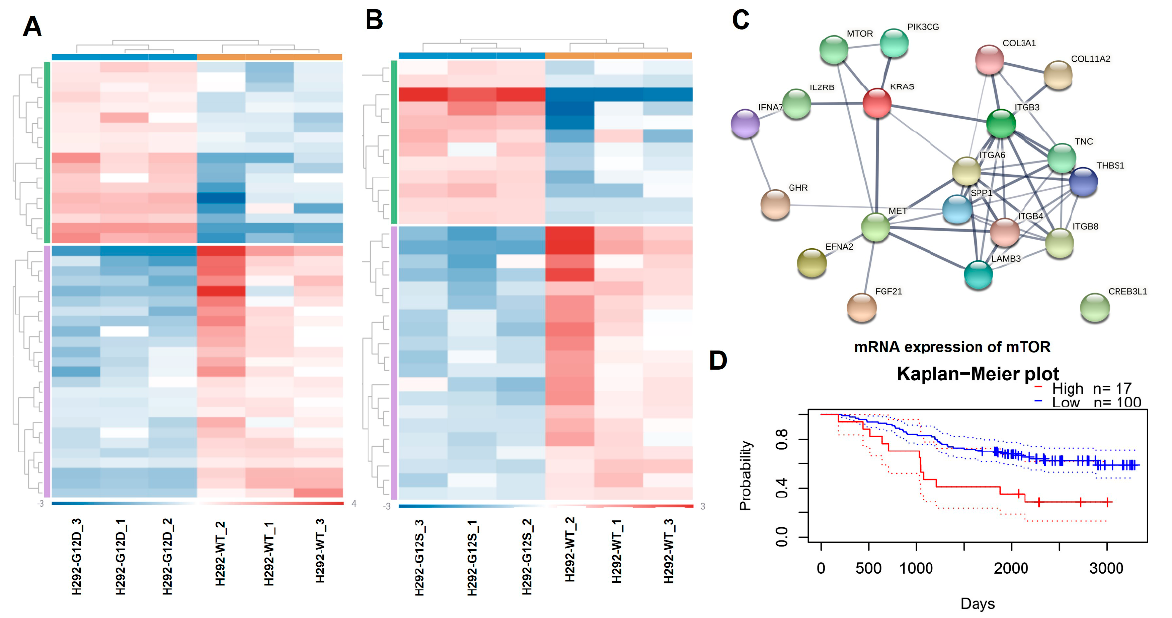
Figure 4. Gene expression analysis of a pan-cancer panel by NanoString™ and functional pathways analysis. Heatmap of genes altered in H292-KRAS mutated cells H292 KRAS -G12D ( A ) and H292 KRAS -G12S ( B ) compared to H292- KRAS wild-type. In red represents the overexpressed genes, and in blue, the down expressed genes. Genetic interaction network associated with KRAS mutations on String platform ( C ). Each circle represents a gene (node) in this figure, and each connection represents a direct or indirect connection (edge). Kaplan–Meier plot survival of mTOR expression in a cohort of NSCLC patients ( n = 117) by PrognoScan analyses ( D ).